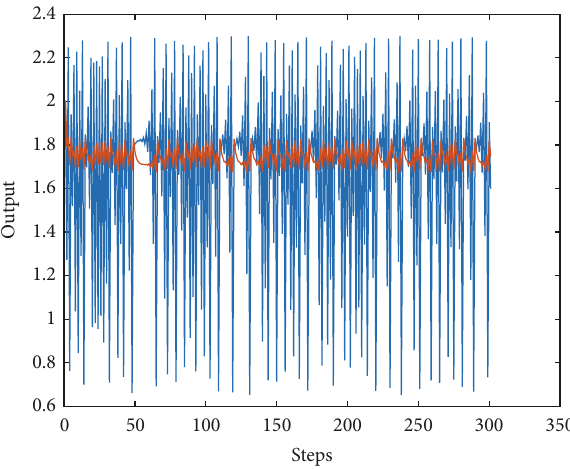
Figure 2: Original output of